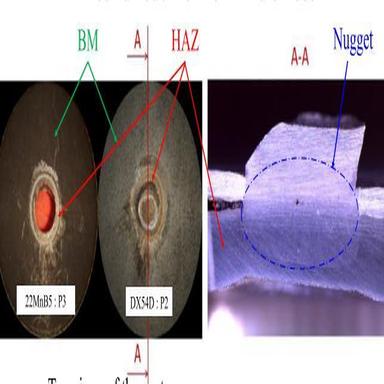
Mixed Pull-out/Inter-facial failure mode of three-sheet spot weld for